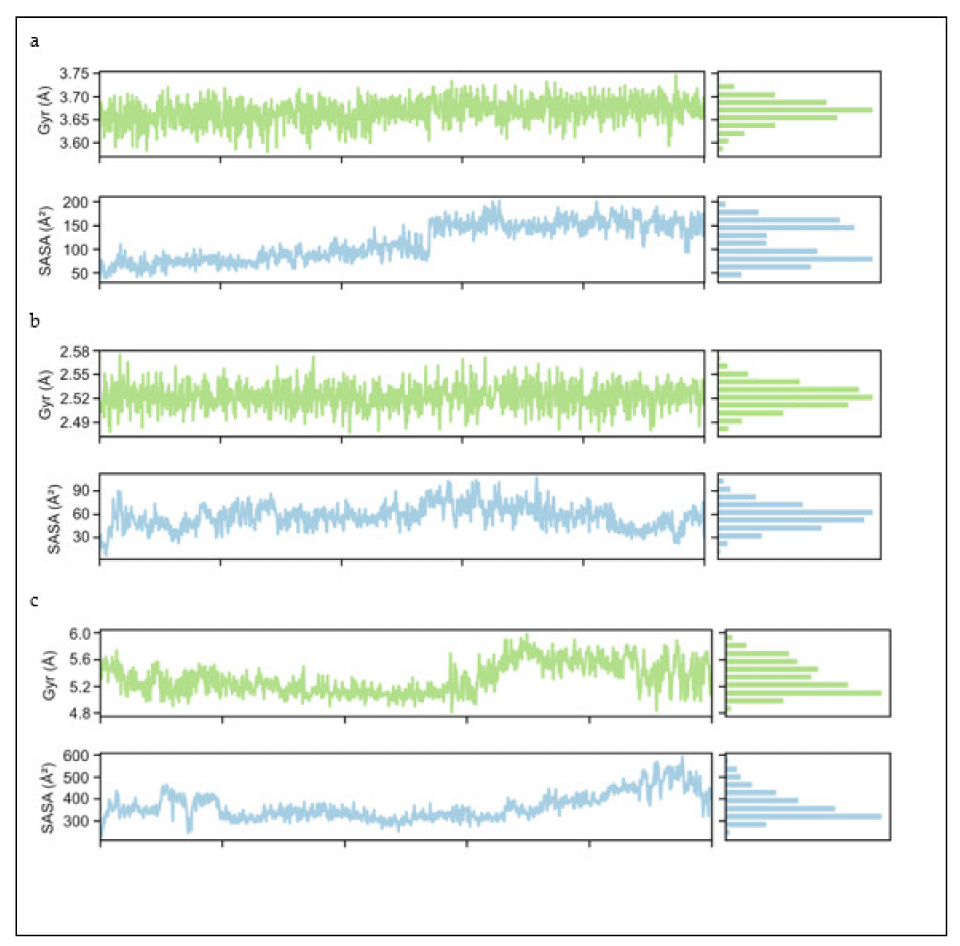
Figure 5. The time frame evolution against the radius of gyration (rGyr) for kaempferol with alpha-glucosidase ( a ), gallic acid with alpha-glucosidase ( b ) acarbose with alpha-glucosidase ( c ) and solvent accessible surface area (SASA) kaempferol, with alpha-glucosidase ( a ), gallic acid with alpha-glucosidase ( b ) and acarbose with alpha-glucosidase ( c ), respectively .